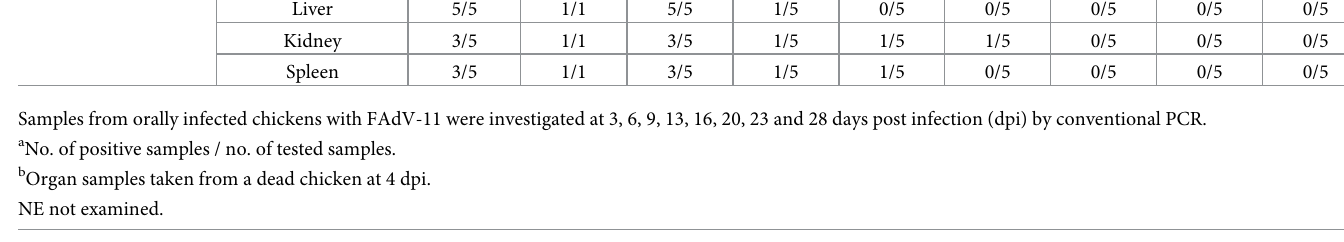
Table 3. FAdV isolation and nucleic acid detection in samples obtained from cloacal swabs and/or organs of infected chickens. FAdV-11 dpi 3 4 b Virus isolation from livers DNA detection Cloacal swabs